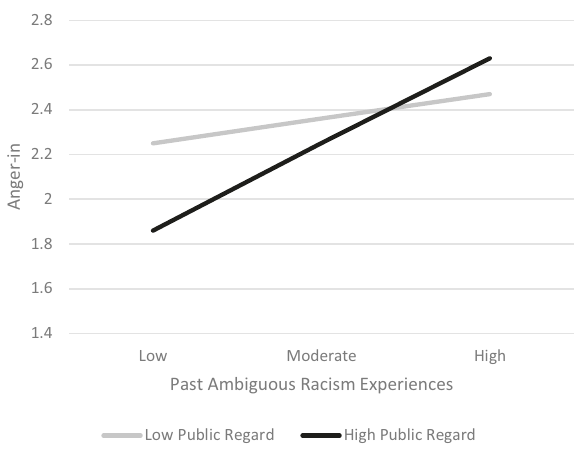
Fig. 1 Mean ratings of anger-in as a function of past experiences of ambiguous racism and the moderating role of perceived public regard for Blacks in the survey study. When participants believed that Blacks were held in low public regard (1 SD below the mean), ambiguous racist experiences were not related to anger-in. As perceived public regard became higher (1 SD above the mean), there was a increasingly positive relation between experiencing ambiguous racism and holding